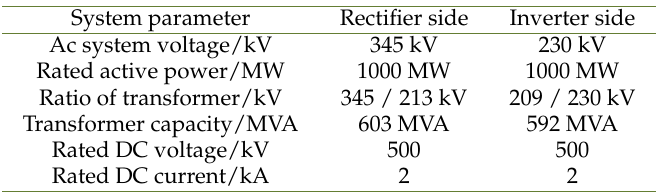
Table 1. Main parameters of LCC system.